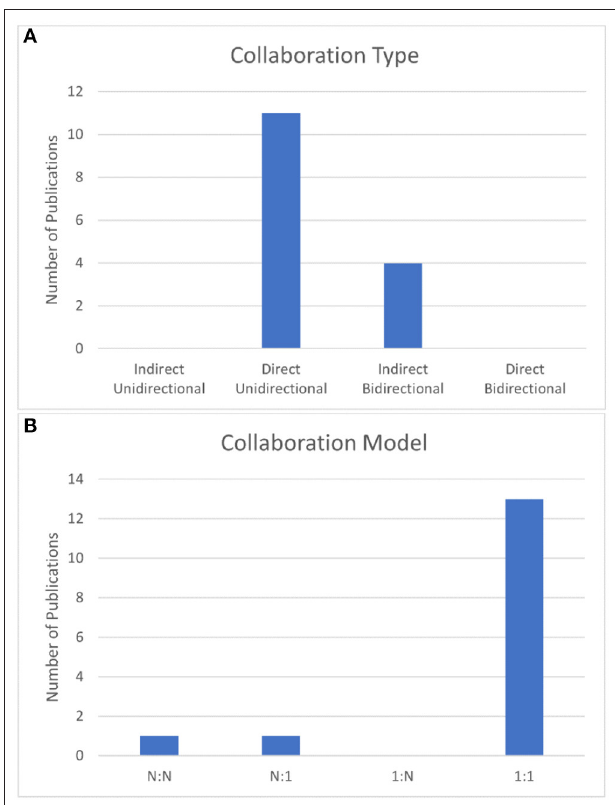
FIGURE 5 | (A) Number of papers that employ each collaboration type. (B) Number of papers that employ each collaboration